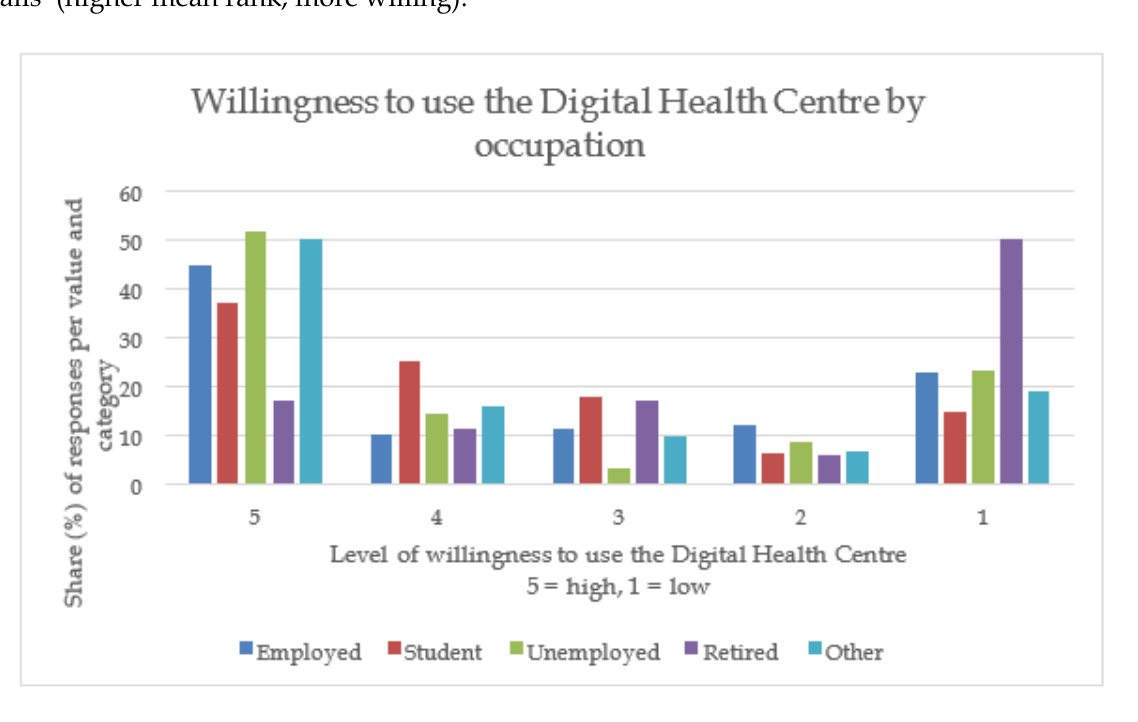
Figure 13. Willingness to use the Digital Health Centre and occupation. Percentage per reported value on scale 5-1. Employed n=92 (100%), Student, n=68 (100%), Unemployed n=35 (100%), Retired n=36 (100%), Other n=32 (100%). Total